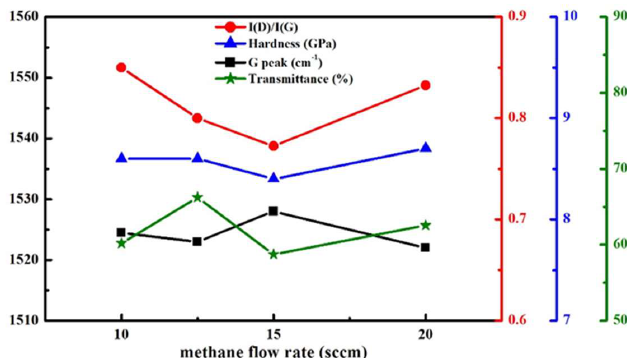
Figure 4. The analysis of DLC properties and transmittance at the different CH 4 flow rates with RF bias of 400 V and DC power of 50 W. (thickness = 135 ± 10 nm)